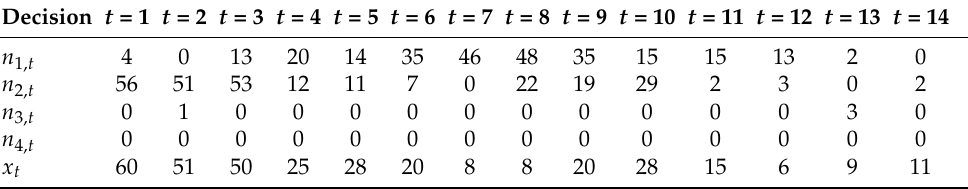
Table 3. Hospital optimal decision scheme for dynamic bed allocation and admission